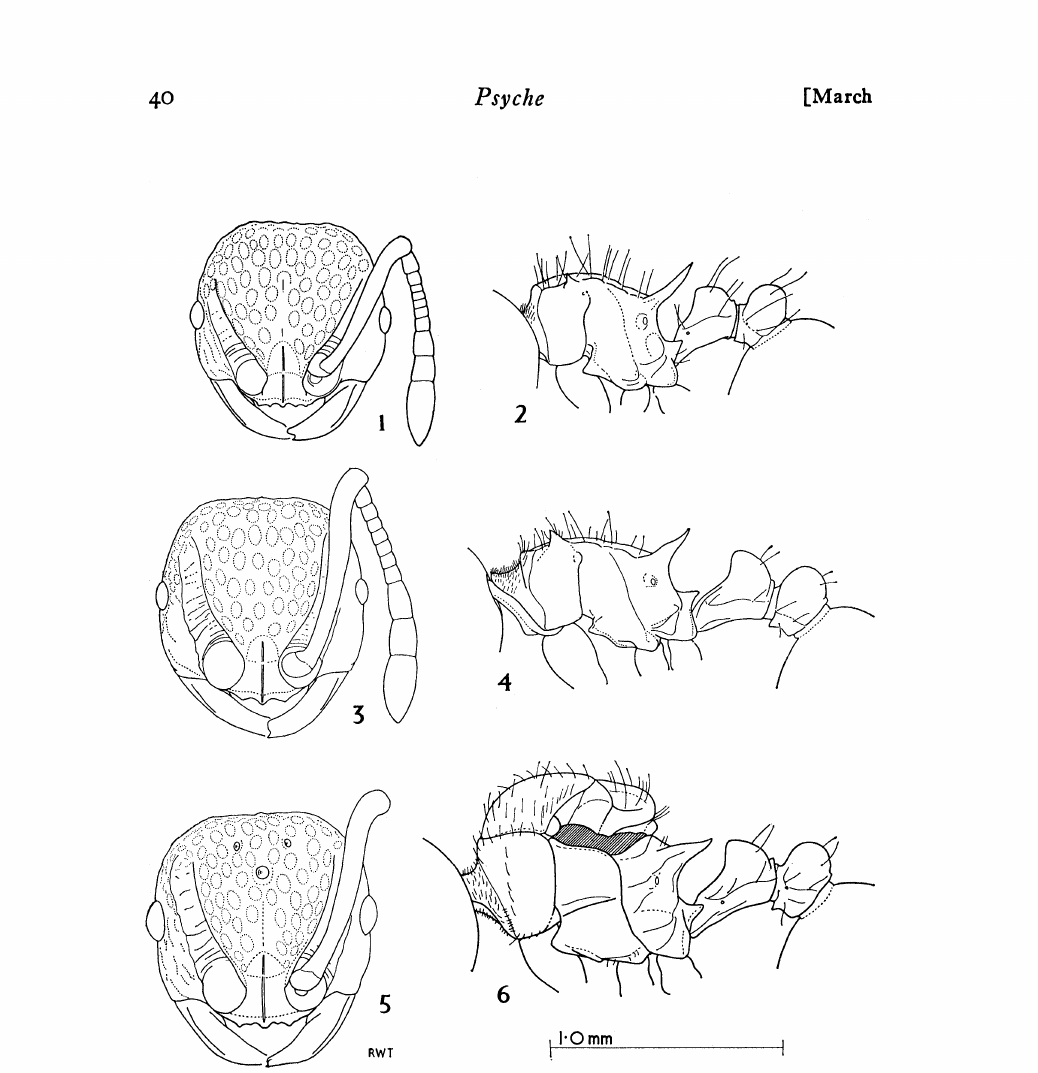
Figures 1-6: North Queensland species of Pristomyrmex [oeolatus species- group uP. [o,e’olatus n. sp., holotype worker: fig. 1, head, frontal view; fig. 2, mesosoma, petiole and postpetiole, lateral view. rap. thoracicus n. sp., holotype worker: fig. 3, head, frontal view; fig. 4, mesosoma, petiole and postpetiole, lateral view. Paratype female: fig. 5, head, frontal view; fig. 6, mesosoma, petiole and postpetiole, lateral